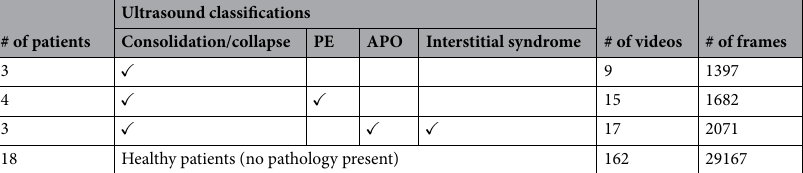
Table 1. Describes the pathology distribution among patients, after Dataset Review and exclusion (Fig. 2). Abbreviations: Acute Pulmonary Oedema (APO), Pleural Effusion